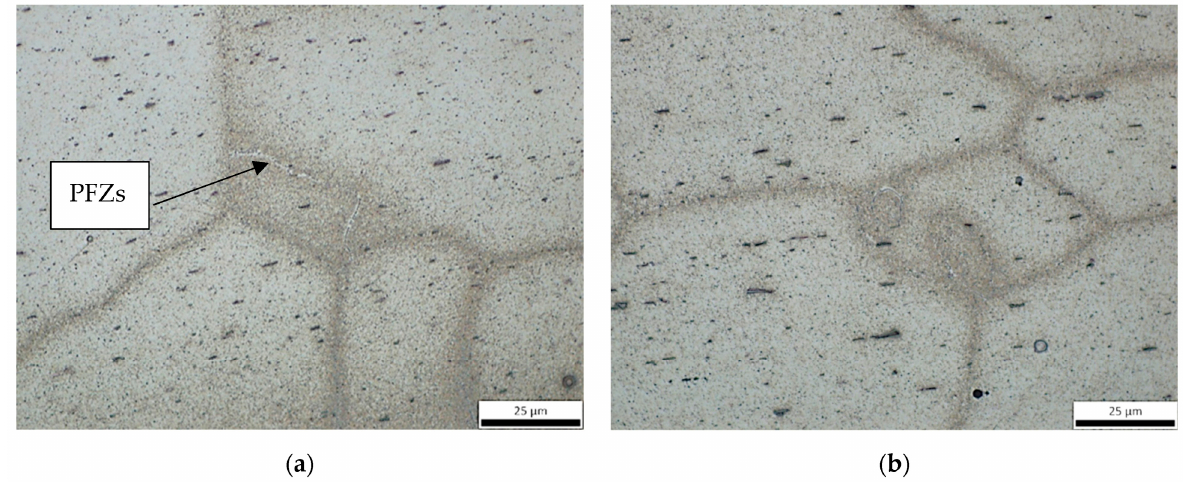
Figure 4. PFZs formation in the WQ sample ( a ) and in the SC sample ( b